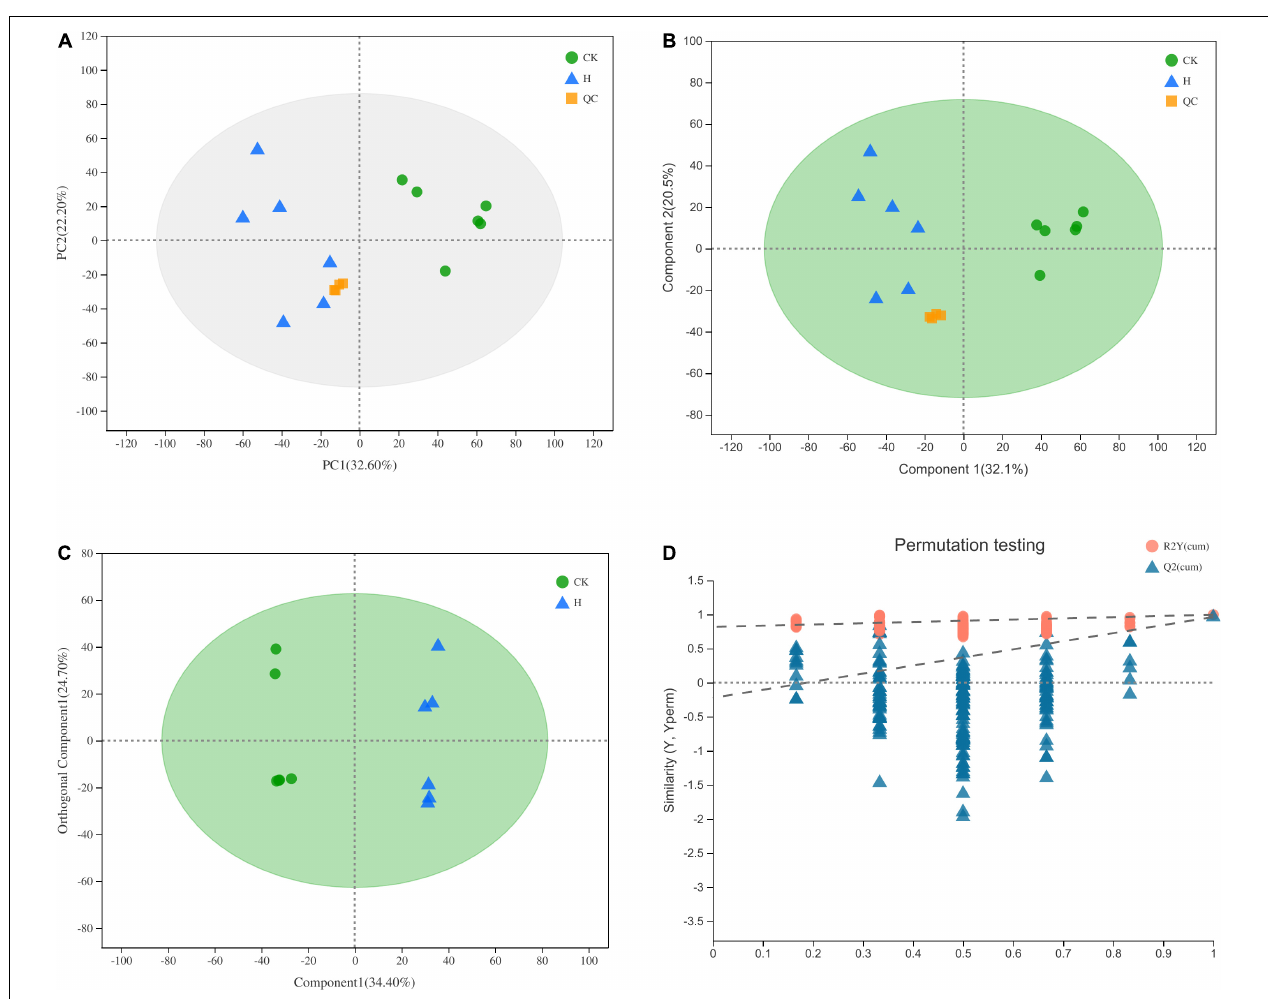
FIGURE 2 | PAC (A) , PLS-DA (B) , OPLS-DA (C) score plots and OPLS-DA model permutation test (D) of metabolites for comparison between AMM and control